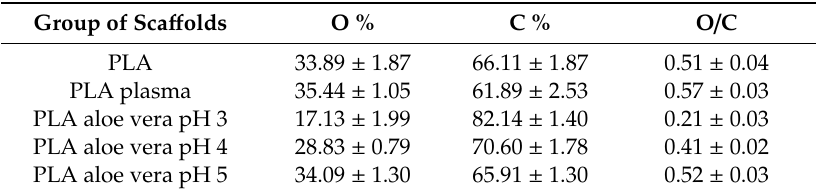
Table 1. XPS results, including the oxygen and carbon content of the surface and the O/C ratio of the non-treated, plasma-treated and coated samples analyzed.